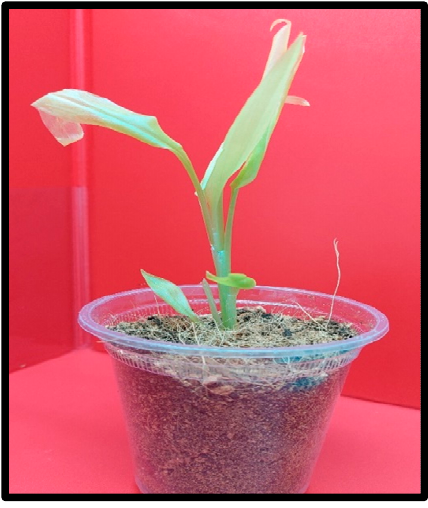
Figure 5. Plantlet during acclimatization in the potting medium of cocopeat and peatmoss.